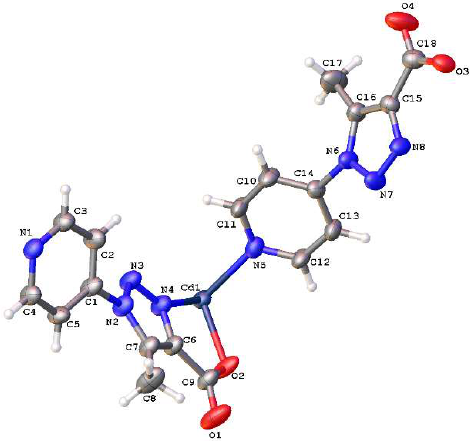
Figure 5. The asymmetric unit of compound 2 .